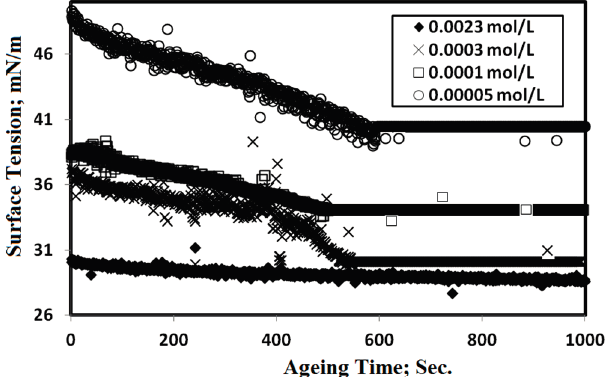
Figure 5. Relation between surface tension and ageing time of different aqueous solutions of OA-TS at 25